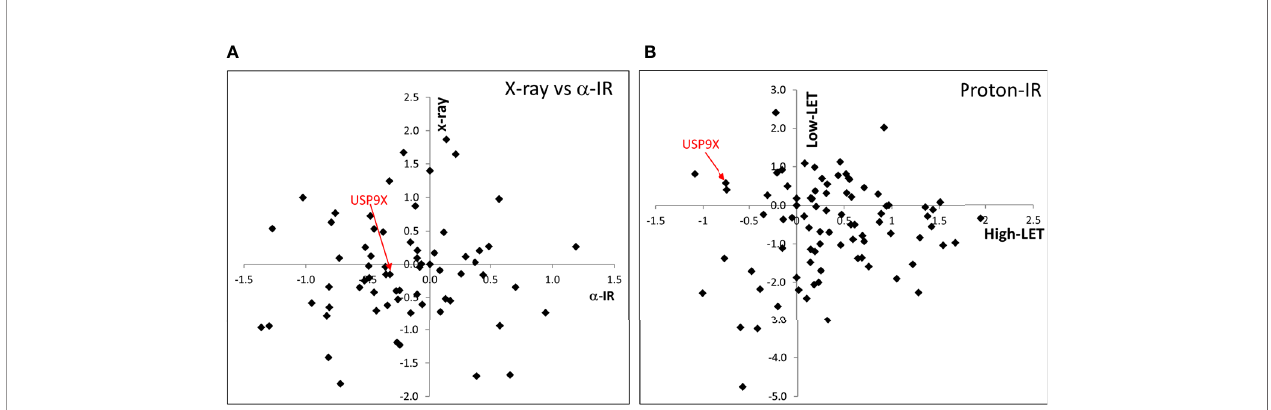
FIGURE 1 | siRNA screen of DUBs modulating cell survival following high and low LET radiation. HeLa cells were transfected with siRNA (pool of 4 oligonucleotides) targeting individual DUBs for 48 h, and irradiated with either (A) 0.5 Gy a -particles or 1 Gy X-rays, or (B) 2 Gy relatively high-LET protons or 2 Gy low-LET protons. Clonogenic survival was analyzed from a single experiment (using triplicate samples) and normalized against the mock-treated control. Results are shown as a log 2 plot, and indicated is the clonogenic survival following USP9X depletion. Data has been adapted from